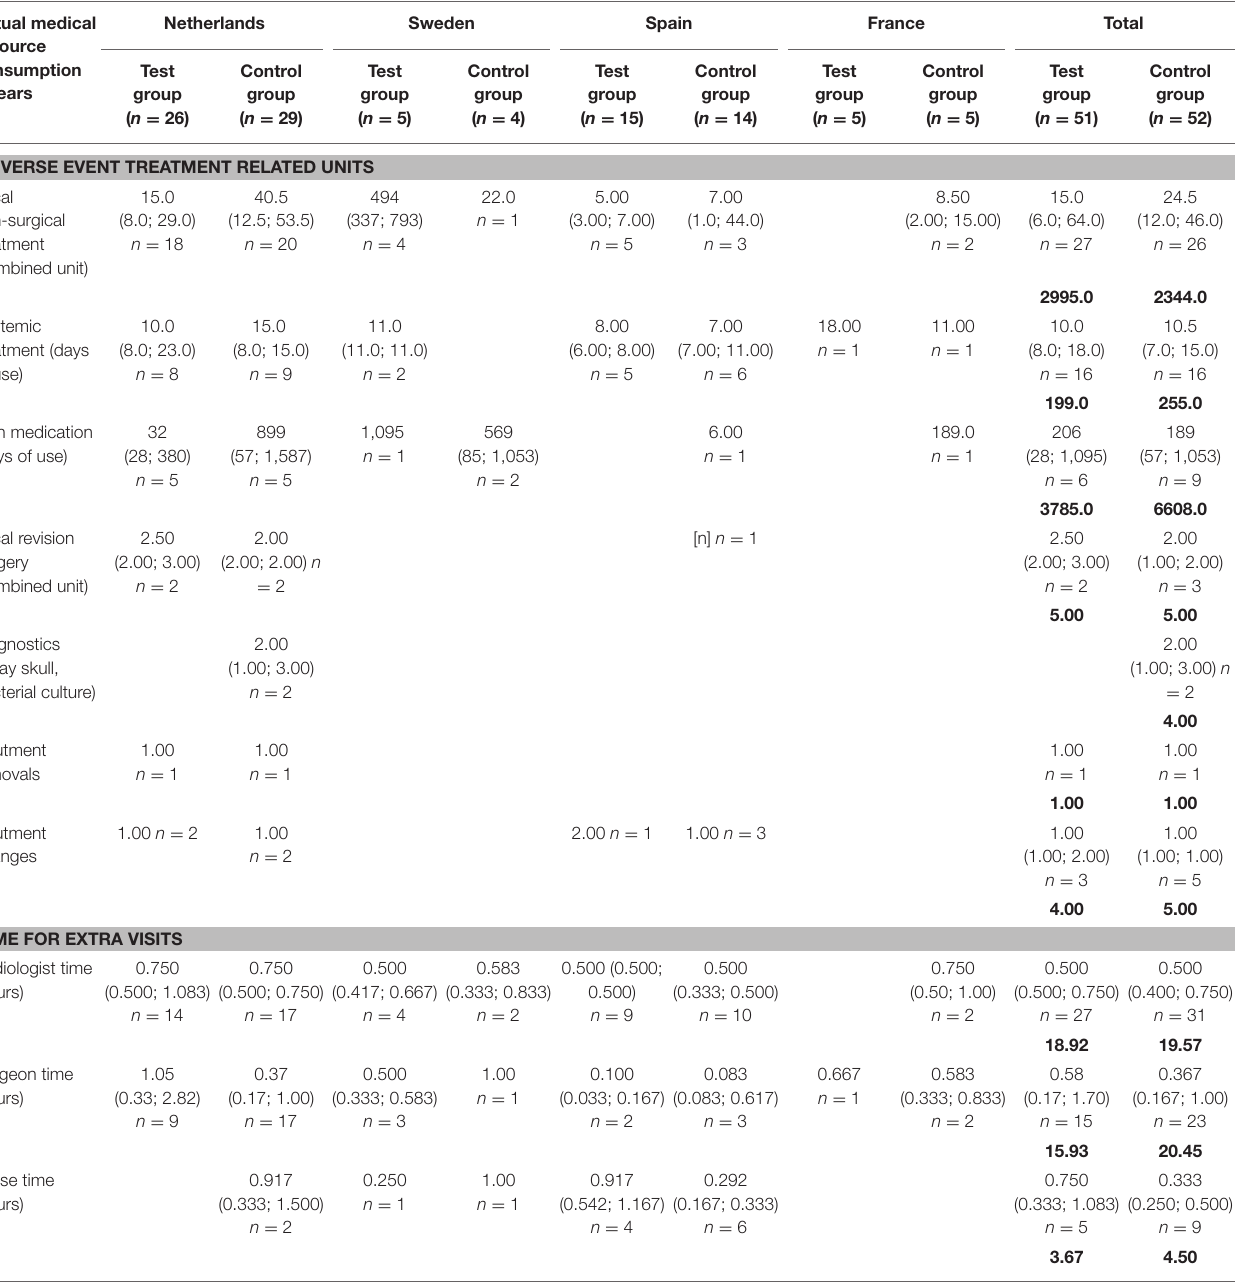
TABLE 2B | Units per country after 3